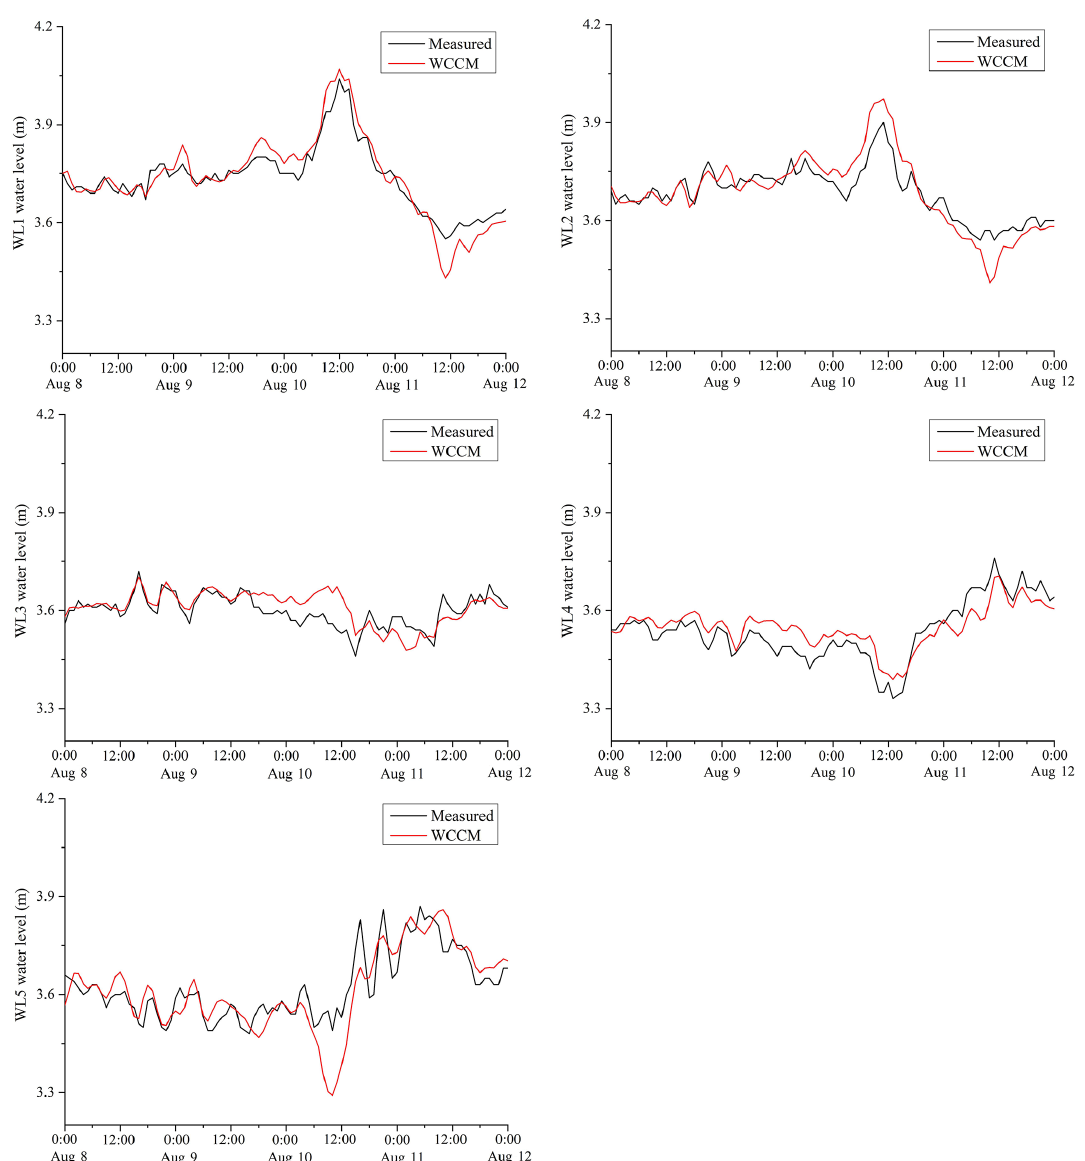
Figure 6. Comparison between the WCCM-simulated and measured water levels at the WL1–WL5 stations during the 2015 summer obser-